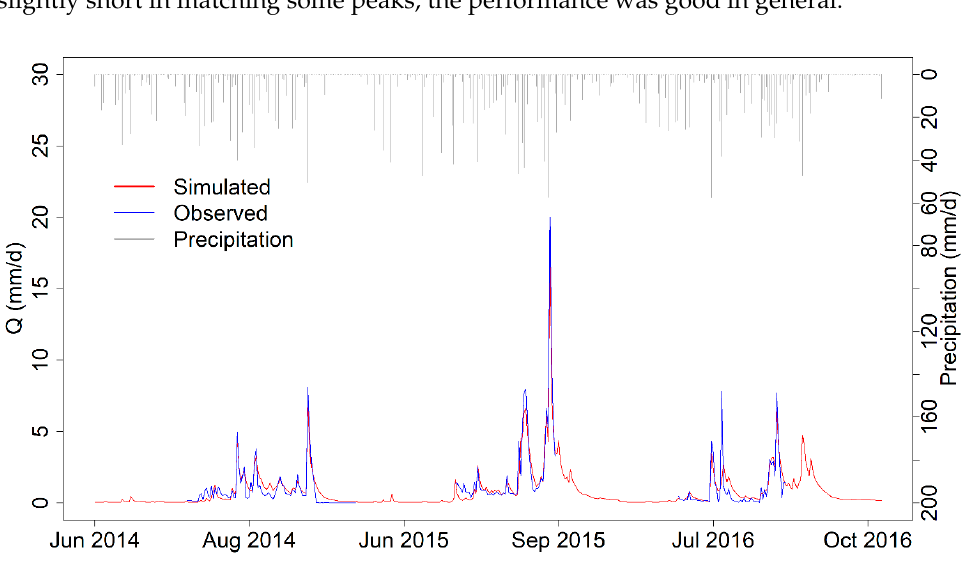
Table 5. Non ‐ recalibrated Mebar model performance in the period 2014–2015 and 2016.